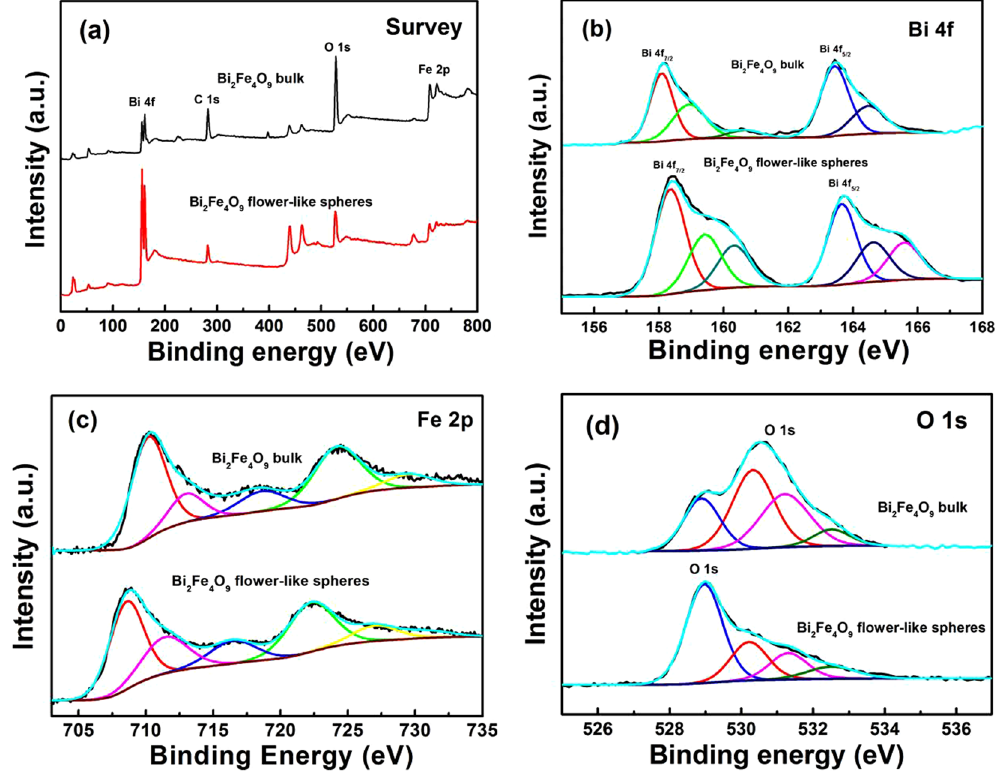
Figure 5. ( a ) Survey XPS spectrum of Bi 2 Fe 4 O 9 and etched flower-like Bi 2 Fe 4 O 9 samples; The high-resolution XPS spectra of ( b ) Bi 4 f, ( c ) Fe 2p, ( d ) O 1 s.